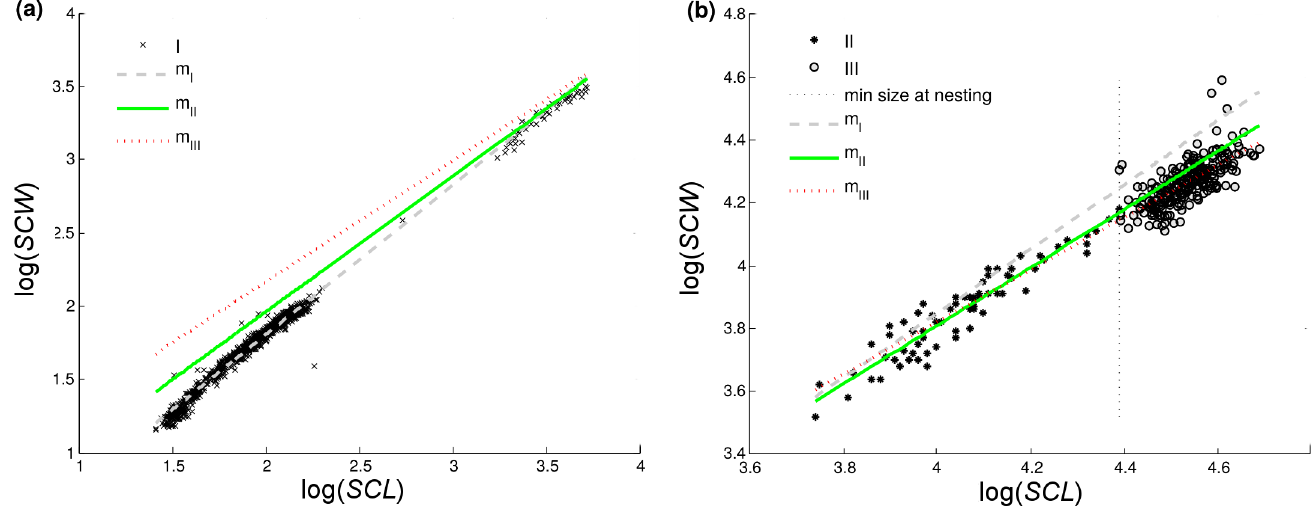
Fig 3. Predictions of log( SCW ) by regression equations ‘ m I ’ , ‘ m II ’ , and ‘ m III ’ . Regression equations are specific for life stage subsets ‘ I ’ , ‘ II ’ , and ‘ III ’ (respectively). Panel (a): subset ‘ I ’ , panel (b): subsets ‘ II ’ and ‘ III ’ . Parameters for the equations are provided in Table 5.